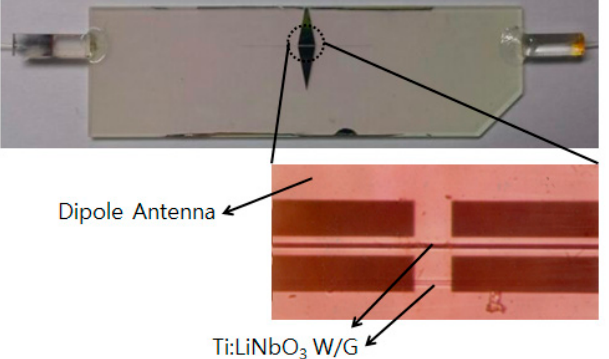
Figure 4. Photograph of the implemented device with pig-tailed optical fibers. W / G is the abbreviation for